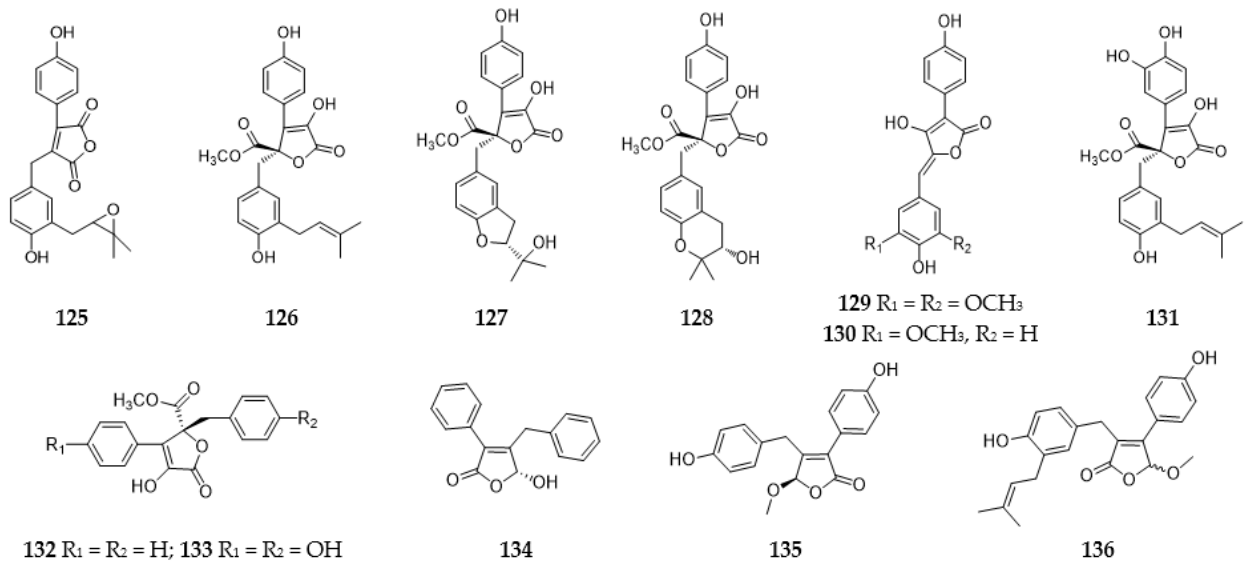
Figure 8. Aspergillus -derived lignans ( 125 – 136